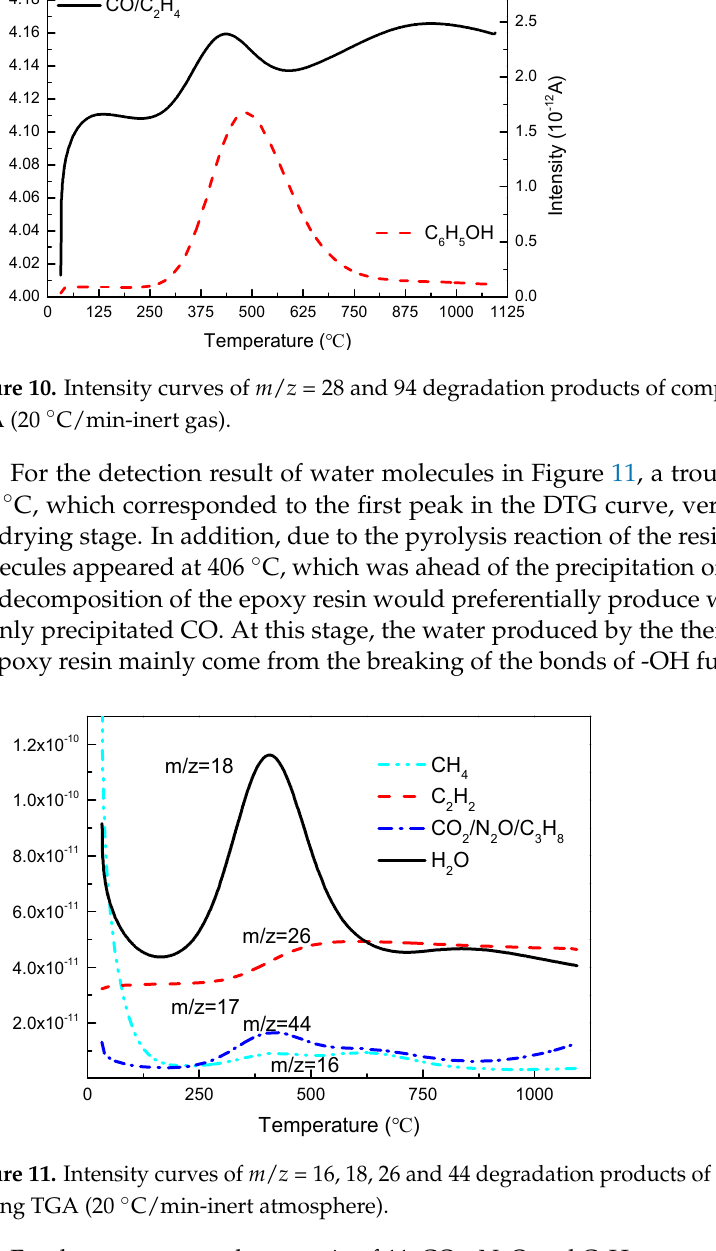
Figure 10. Intensity curves of m / z = 28 and 94 degradation products of composite released during TGA (20 °C/min-inert gas).